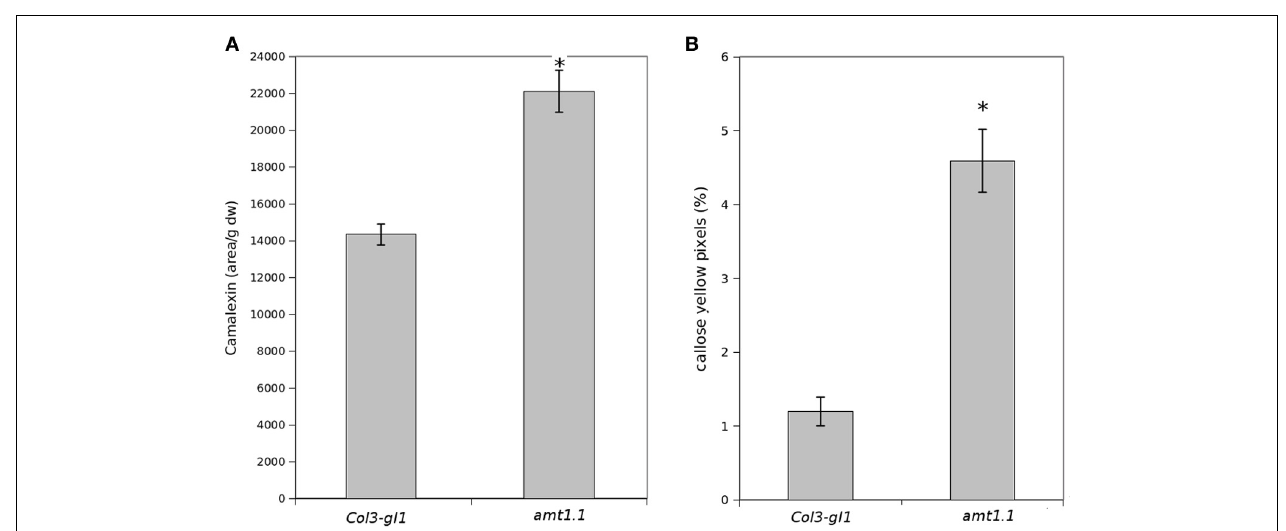
by normalizing the chromatographic area for each compound with the dry weight of the corresponding sample. Leaf material from 15 individual plants for P.syringae (A) resistanceassaysand150plantsfor P.cucumerina (B) resistance assayswerepooledtogetherforeachtreatment × genotypecombination.Data represent average three independent experiments ± SD; n = 3.